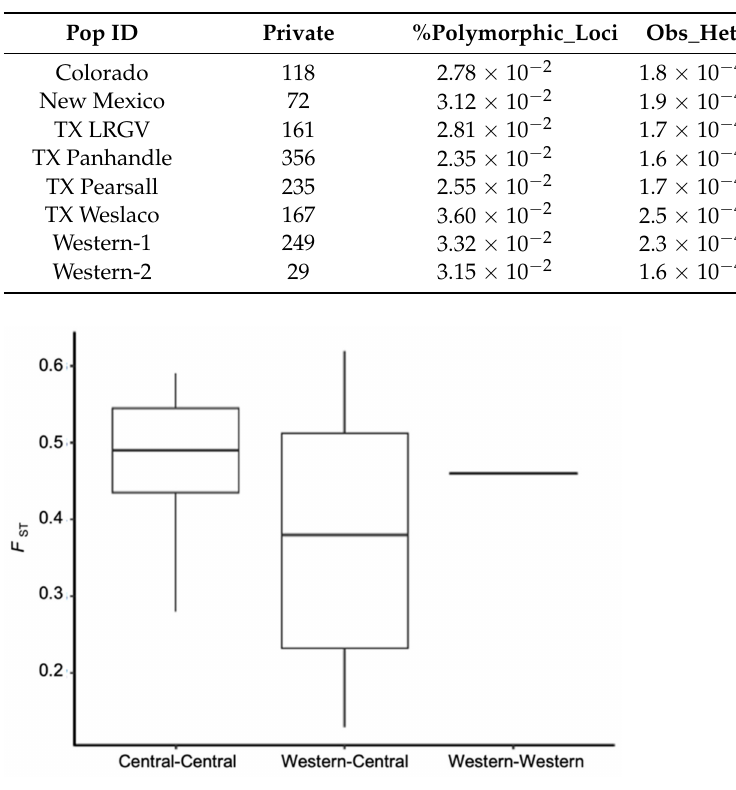
Table 3. Summary of genetics statistics calculated by the Stacks. Private refers to number of variable sites unique to each population; %Polymorphic_Loci refers to percentage of polymorphic loci, Obs_He and Exp_Het refer to average observed and expected heterozygosity per locus, respectively.